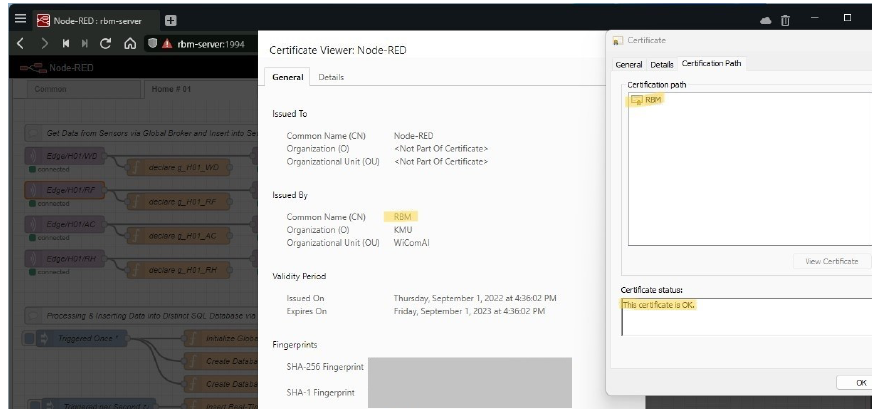
Figure 11. Authorized login in the dashboard.